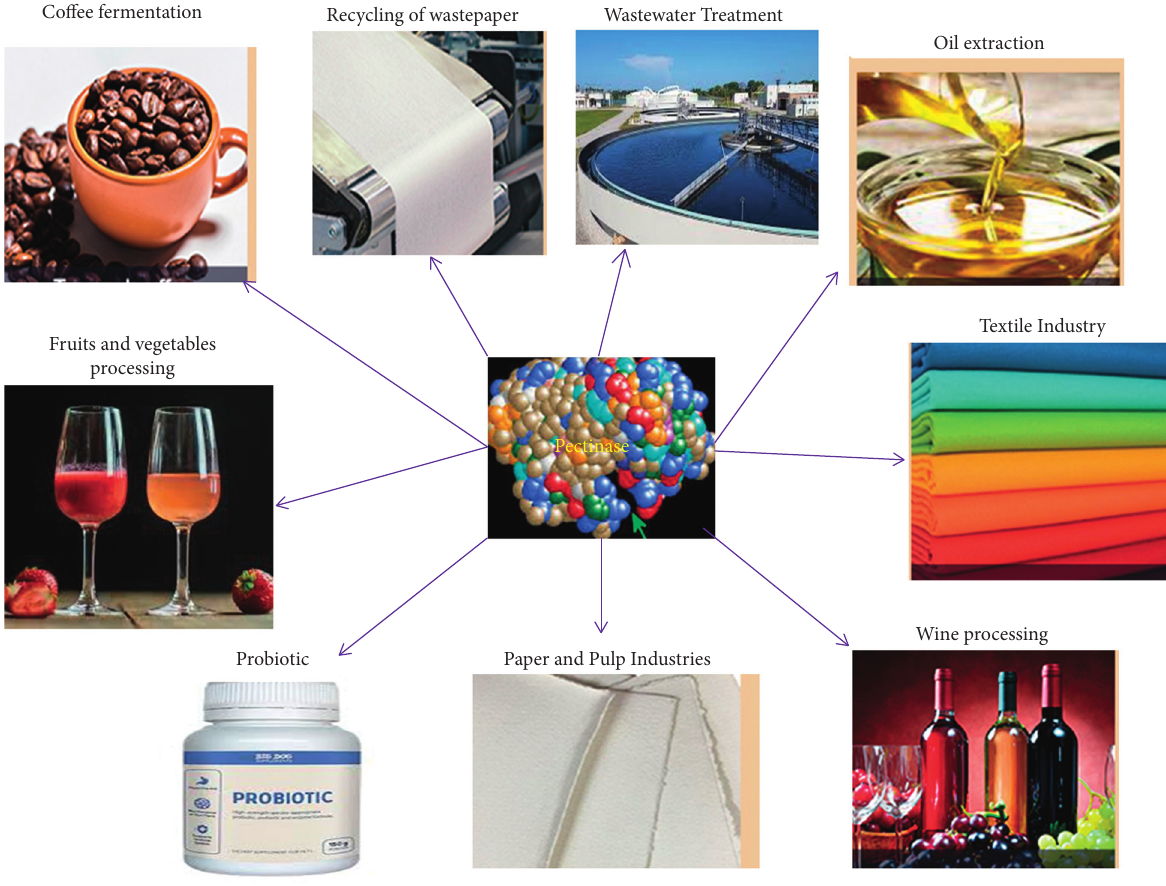
Figure 4: Various applications of pectinases [21, 26,